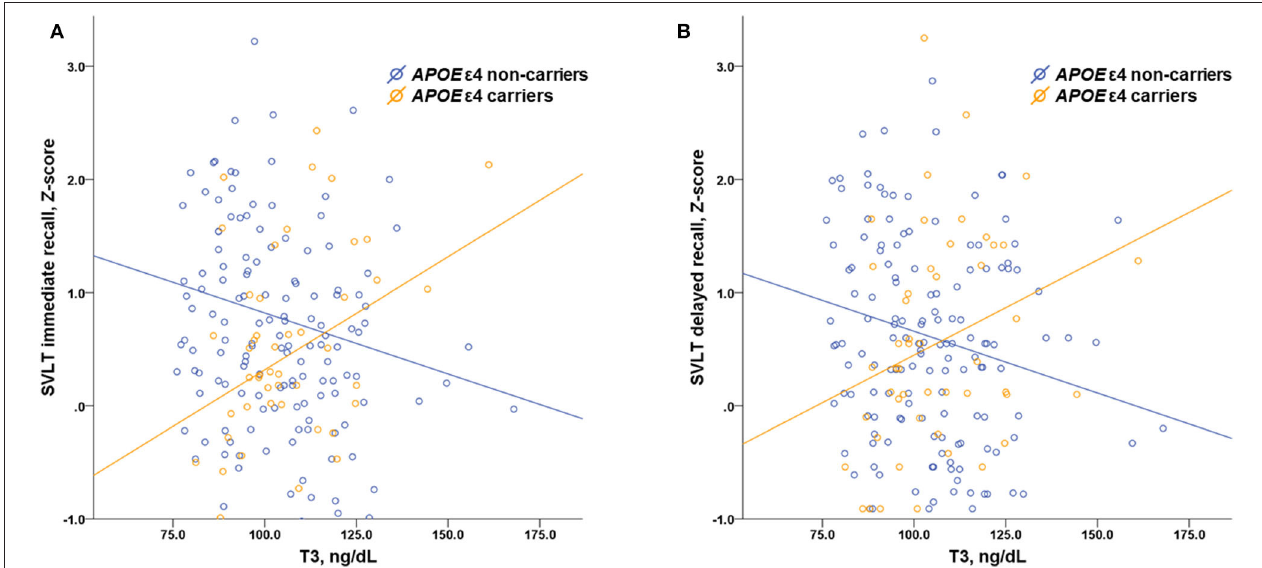
FIGURE 2 | Scatter plots investigating the relation between memory performance and serum T3 levels in patients with SCD according to APOE ε 4 status showing interaction effects of APOE ε 4 status and T3 level on the results of (A) the SVLT immediate recall ( p = 0.032) and (B) the SVLT delayed recall ( p = 0.004) task. T3, triiodothyronine; SCD, subjective cognitive decline; APOE , apolipoprotein E; SVLT, Seoul verbal learning